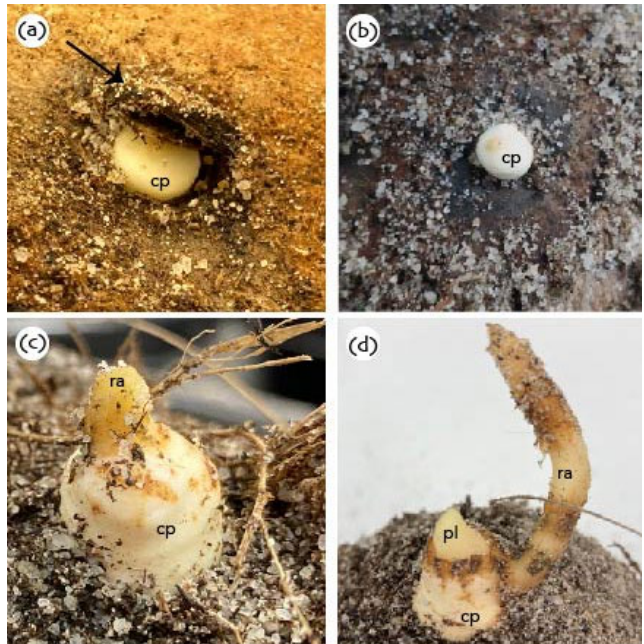
Figure 5. ( a ) Cotyledonary petiole protruding through the endocarp: arrow shows the displacement of the soft eye; ( b ) cotyledonary petiole protruding through the endocarp; ( c ) radicle emerging from the cotyledonary petiole; ( d ) radicle elongation and emergence of the plumule. cp: cotyledonary petiole; ra: radicle; pl: plumule.